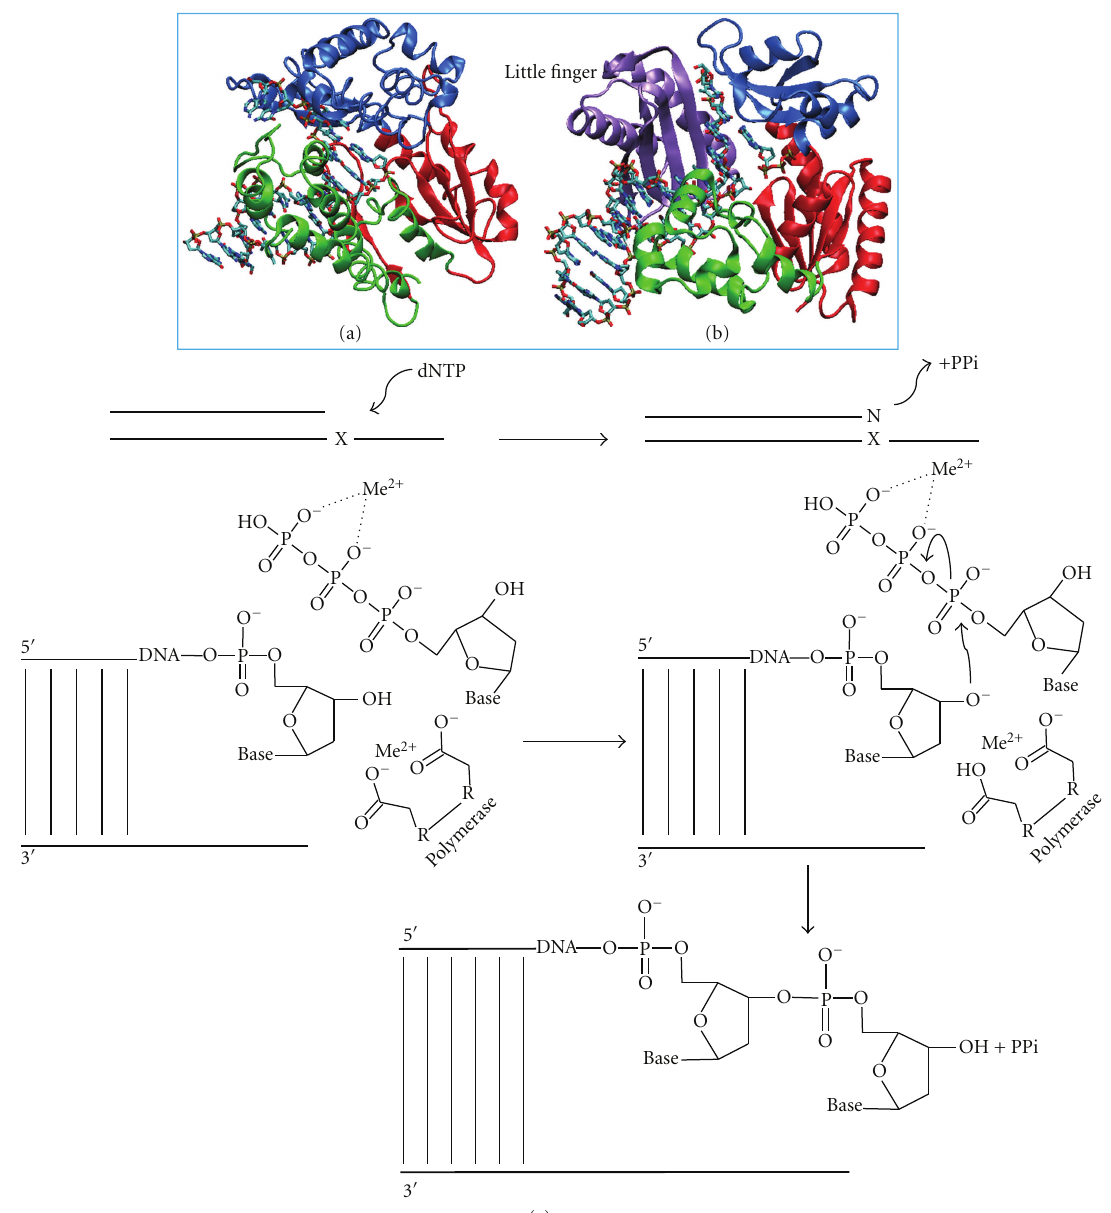
Figure 1: Comparison of the overall folds of (a) a replicative DNA polymerase, Bacillus stearothermophilus DNA pol I [30], and (b) a Y family DNA polymerase, Sulfolobus solfataricus Dpo4 [31]. The respective thumb domains are shown in green, palm domains are in red, and fingers domains are in blue. The little finger domain unique to the Y family DNA polymerases is in purple [31]. The “vestigial” exonuclease domain of Bs pol I has been omitted for clarity [32]. (c) Polymerase catalyzed DNA replication (phosphoryl transfer) reaction. Polymerization of DNA occurs at a free 3 (cid:2) hydroxyl group of the deoxyribose. Polymerases use a divalent magnesium ion (Me 2+ ) to coordinate the negative charges of both the phosphate groups and the aspartic acid or glutamic acid in the active site of the polymerase